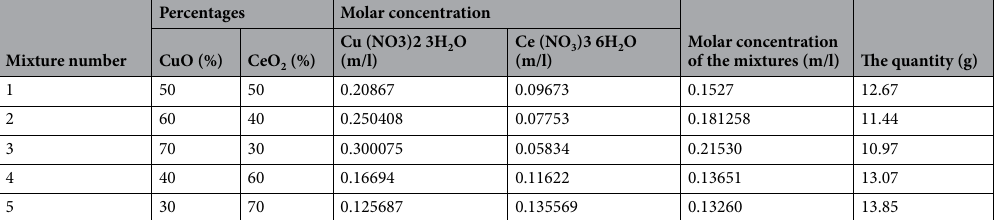
Table 5. The quantities obtained in grams from the mixtures.